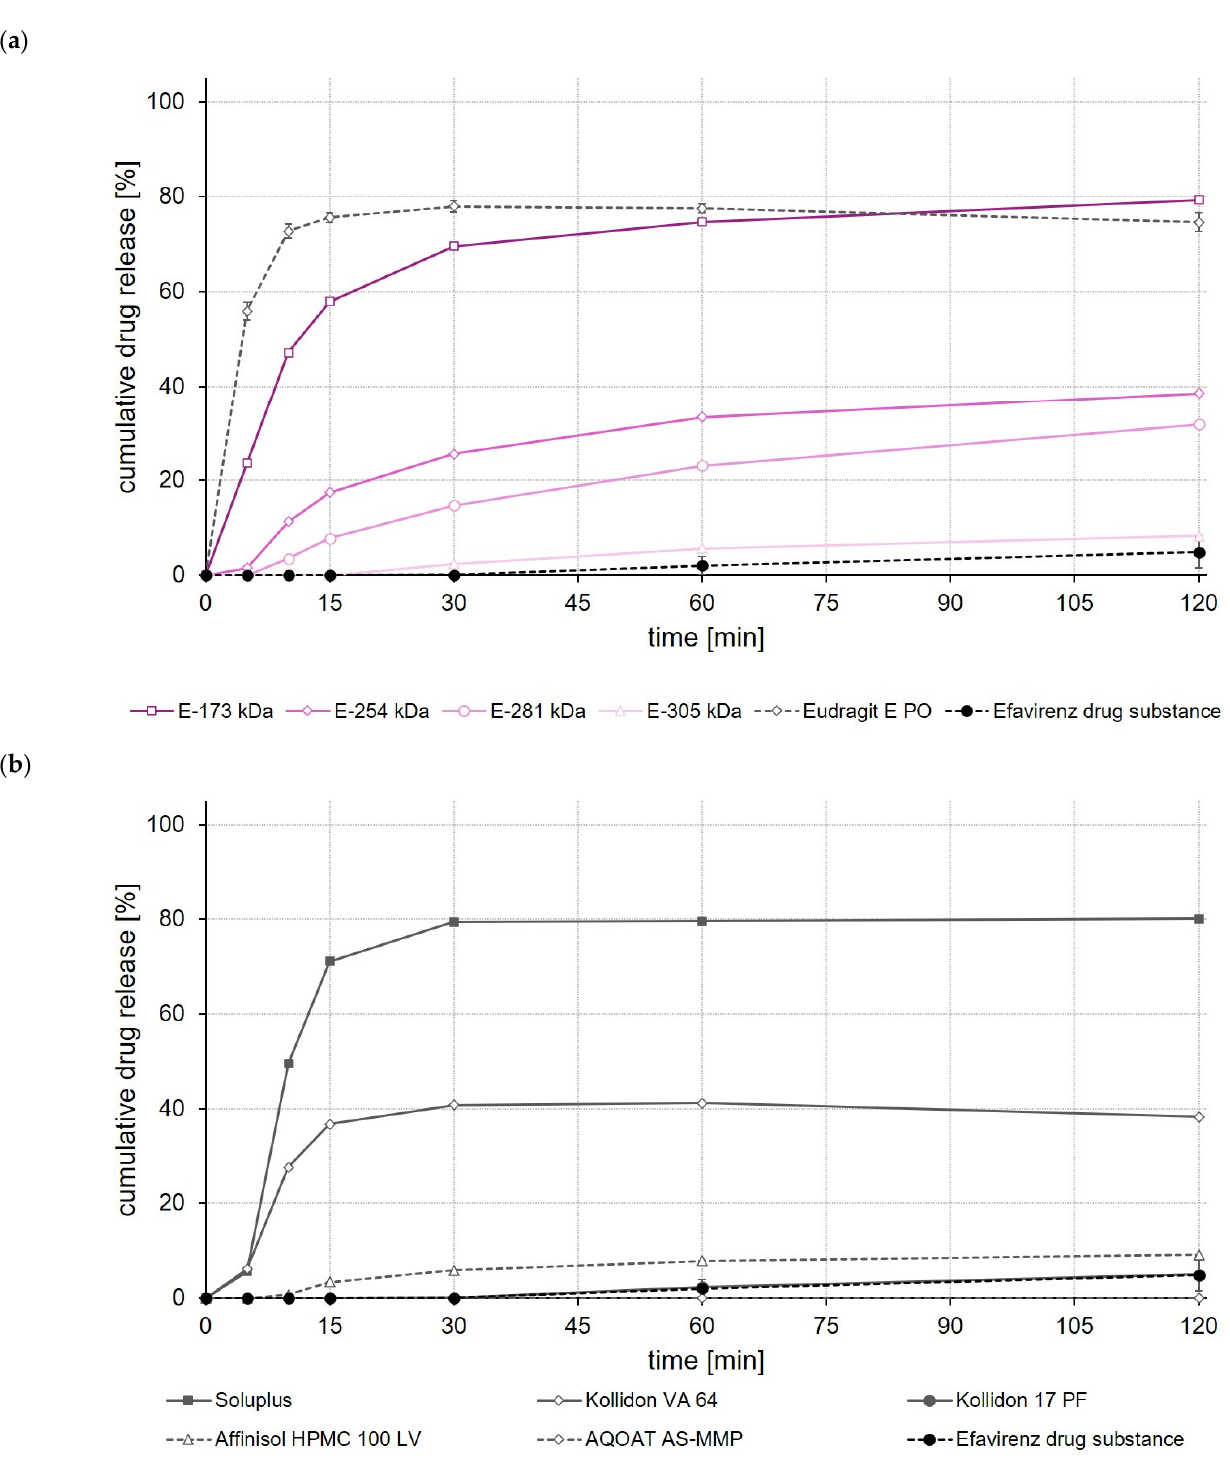
Figure 10. Dissolution profiles of efavirenz drug substance and efavirenz ASDs based on ModE and EPO ( a ), as well as efavirenz drug substance and efavirenz ASDs based on other marketed (co-)polymers ( b ) (after three months of storage at 30 °C/65% RH) in 500 mL 0.1 M HCl in USP apparatus II. Each value designates the mean ± S.D. (n = 3).